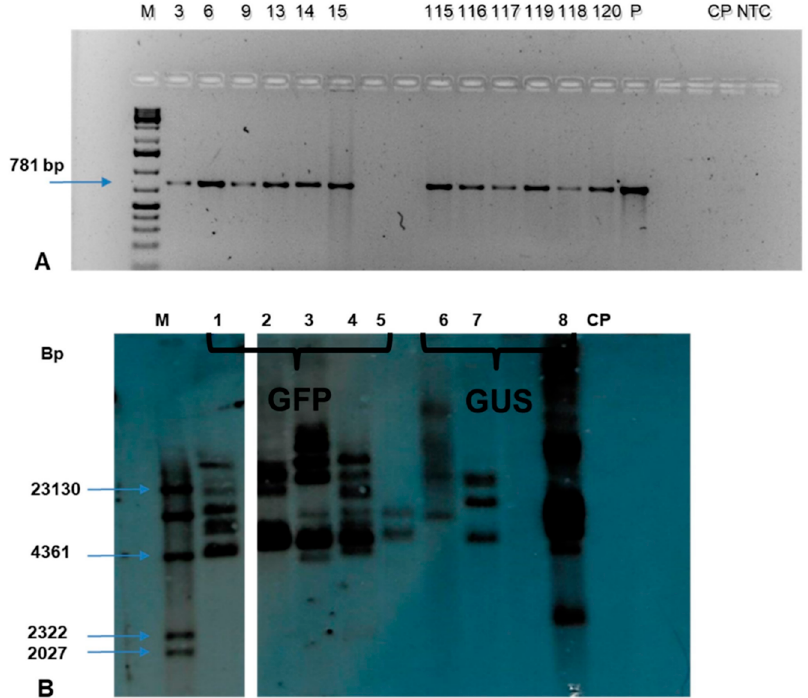
Figure 10. Molecular analysis of transgenic events of plantain cultivar Obino l’Ewai. ( A ) PCR analysis using npt II specific primers. M —DNA ladder sample; 3 – 15 — gfp transgenic events; 115 – 120 — gusA transgenic events; P —plasmid DNA as a positive control; CP —Non-transgenic control plant; NTC —non-template control; ( B ) Southern blot analysis of selected transgenic events using npt II specific probe. M: DIG molecular marker; Samples (1–8)—Transgenic events (GFP event T2-2D, GFP event T4-2D, GFP event T4-3D, GFP event T5-2D, GFP event T5-3D, GUS event T2-3D, GUS event T4-2D, GUS event T4-3D); CP- Non-transgenic control plant.